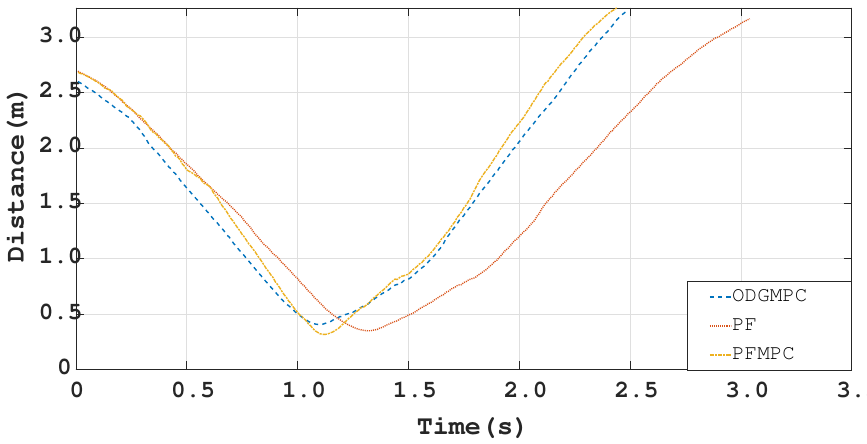
Figure 20. Results of the acceleration from Scenario 2 for a static obstacle.